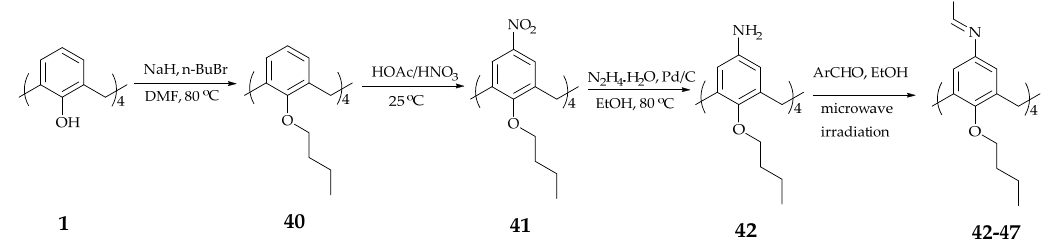
Scheme 3. Synthetic pathway for various derivatives of iminecalix[4]arenes [55].